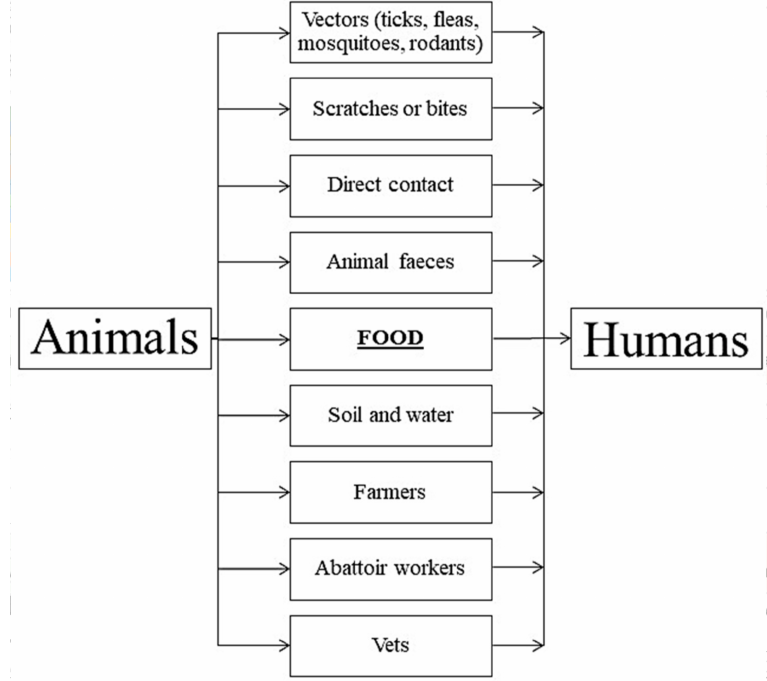
Figure 1. Routes of diseases transmission from animals to humans